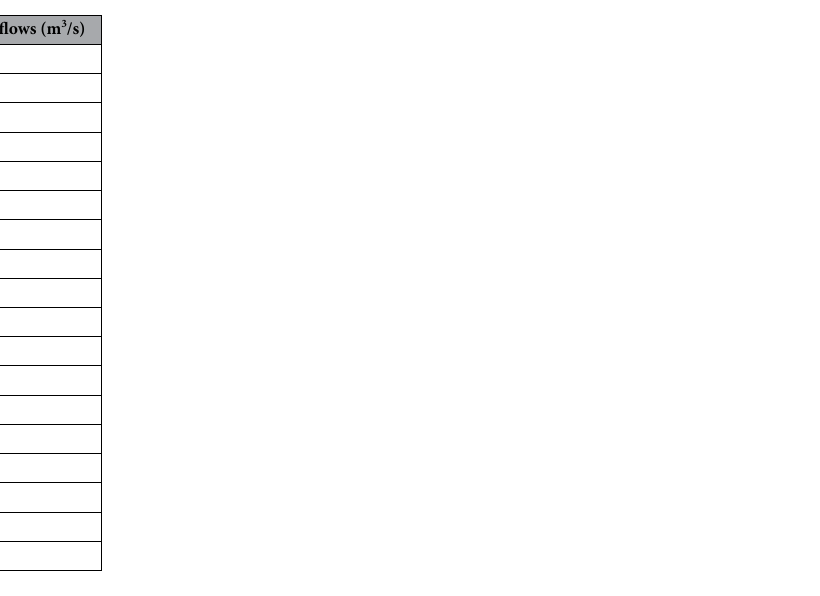
Table 2. Minimum Flows (in cubic meter per second) that retain a % of Area Weighted Suitability at a base flow of 536.112 cubic meter per